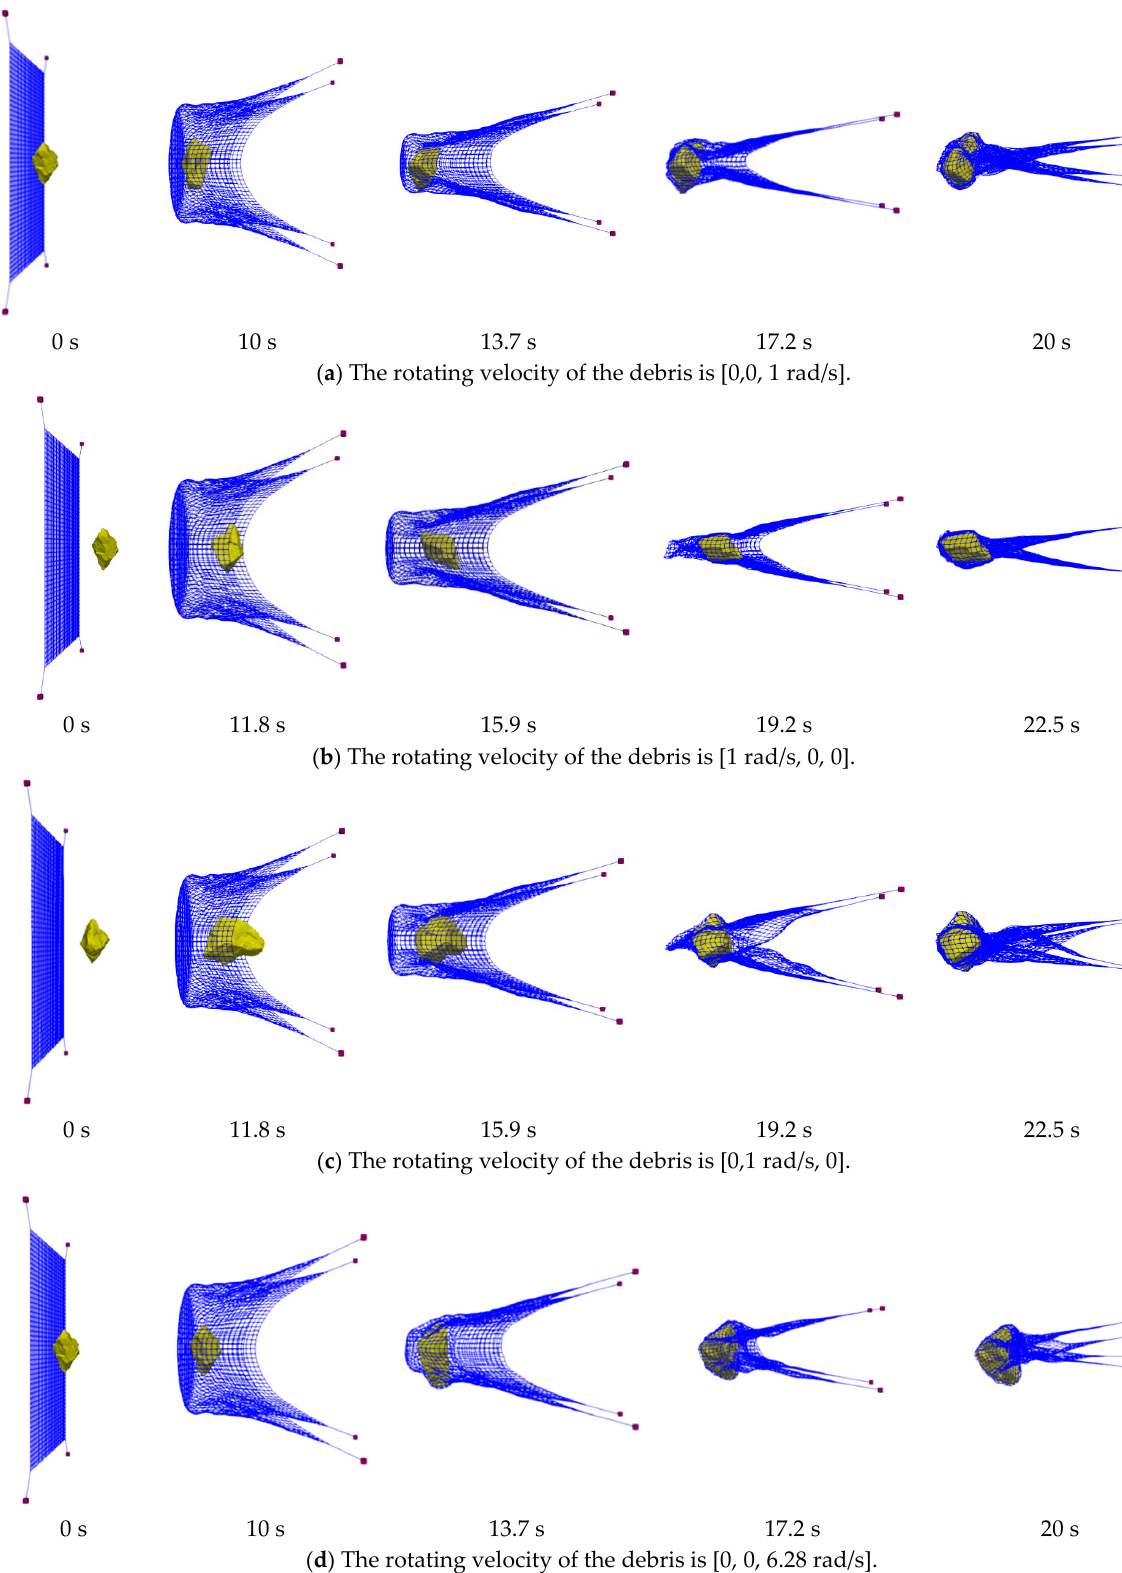
Figure 4. Capture scenarios under different initial conditions. ( a ) The rotating velocity of the debris is [0, 0, 1 rad/s]. ( b ) The rotating velocity of the debris is [1 rad/s, 0, 0]. ( c ) The rotating velocity of the debris is [0,1 rad/s, 0]. ( d ) The rotating velocity of the debris is [0, 0, 6.28 rad/s].